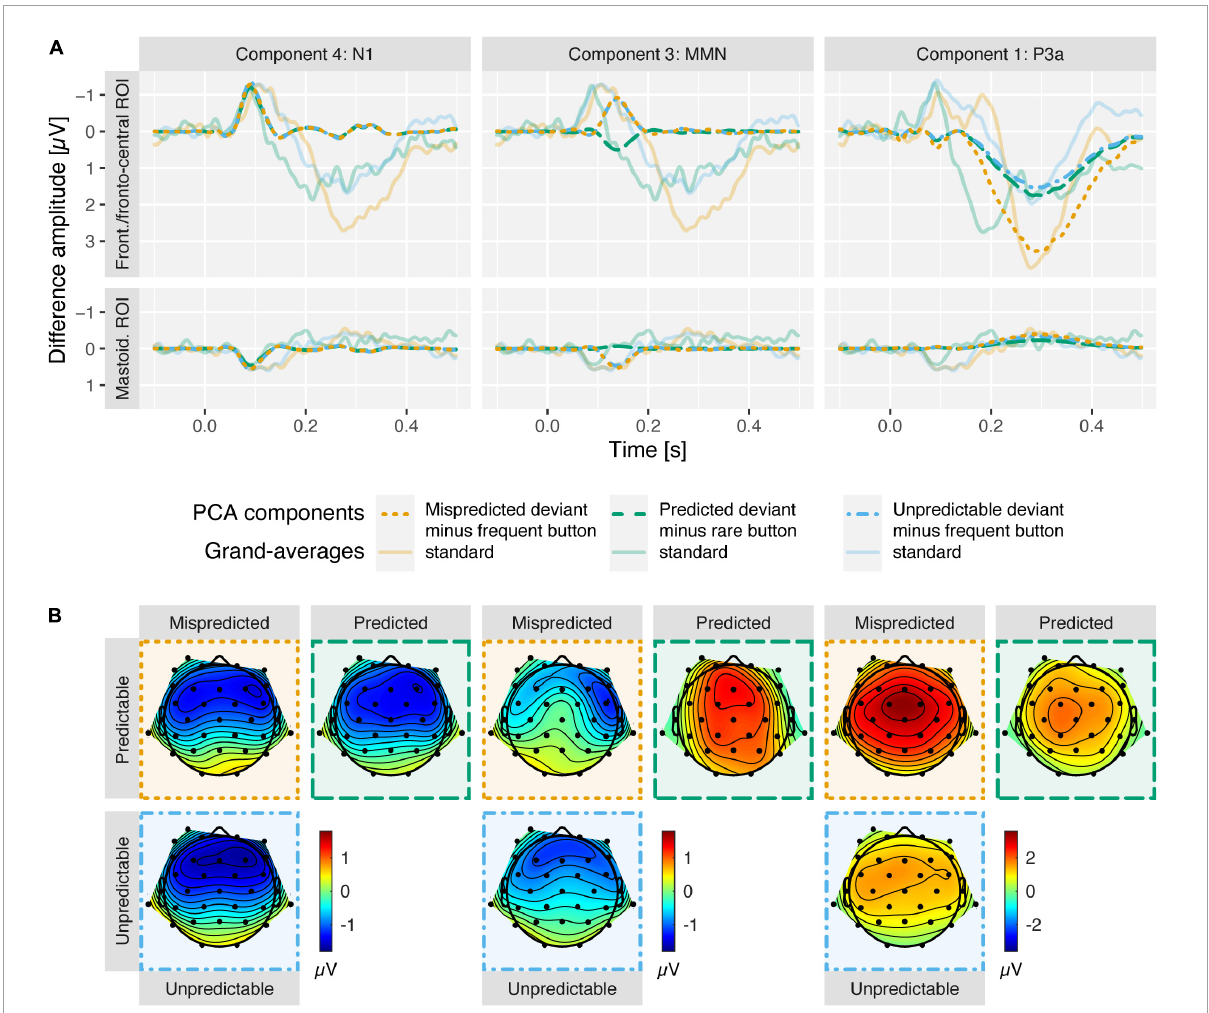
FIGURE4 (A) Deviant minus standard difference waves, separately for N1, MMN, and P3a PCA components in columns one to three (opaque, dashed) at frontal and mastoidal (N1 and MMN) and fronto-central ROIs (P3a). For each column, the respective grand-average ERP differences waves are shown (transparent, solid) to enable a comparison between the time courses of the components scores and the ERPs. Note that N1 component traces overlap for all deviant types and MMN component traces overlap for mispredicted and unpredictable deviants. (B) Deviant minus standard difference topographies for N1 (90 ms), MMN (138 ms), and P3a (282 ms) PCA components at component peak latencies. In both panels mispredicted deviants (orange; minus frequent button standards) and predicted deviants (green; minus rare button standards) from predictable condition and unpredictable deviants (blue; minus frequent button standards) from unpredictable condition are displayed. N1 was enhanced (more negative at frontal, more positive at mastoidal electrode sites) for deviants compared to standards similarly in all conditions. MMN was observed for mispredicted and unpredictable deviants but abolished for predicted deviants. P3a was observed in all conditions but enhanced (more positive at fronto-central electrode sites) in response to mispredicted deviant compared to predicted and unpredictable deviants. Component score differences reveal topographies typical for N1, MMN and